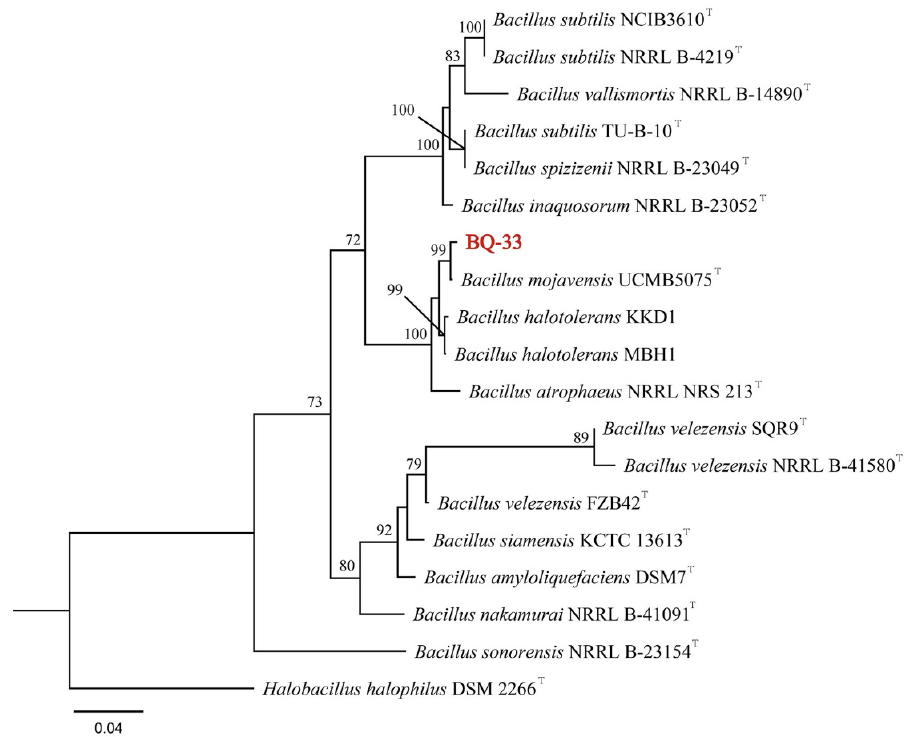
Figure 1. Phylogenetic tree of Bacillus mojavensis BQ-33 based on 16S rDNA and gyrA tandem gene sequences, constructed using the maximum likelihood (ML) method with MEGA 7.0 software. Bootstrap values are based on 1000 repeats. T = type strain.